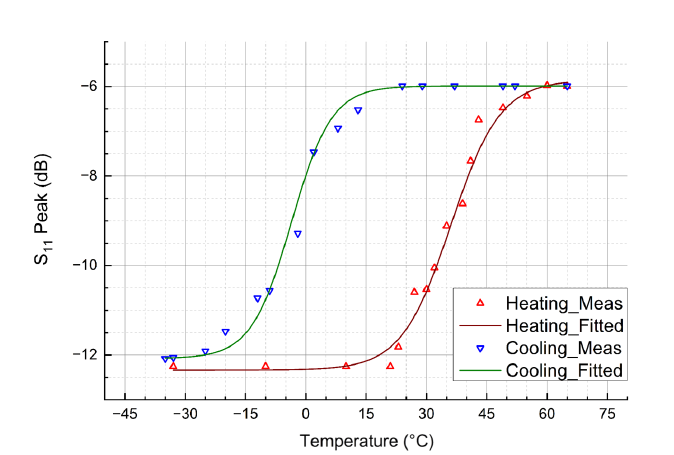
Figure 7. Minimal value of S 11 during the temperature